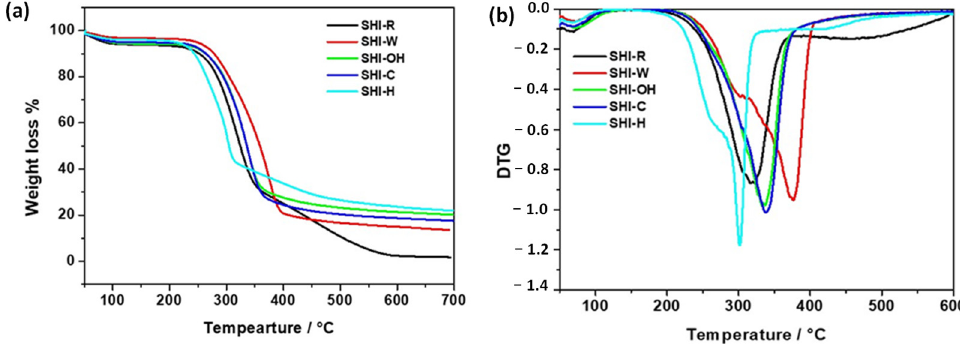
Figure 8. Thermal analysis of untreated (SHI-R) and treated shives (SHI-W, SHI-OH, SHI-C and SHI-H): ( a ) TG curves; ( b ) DTG curves.